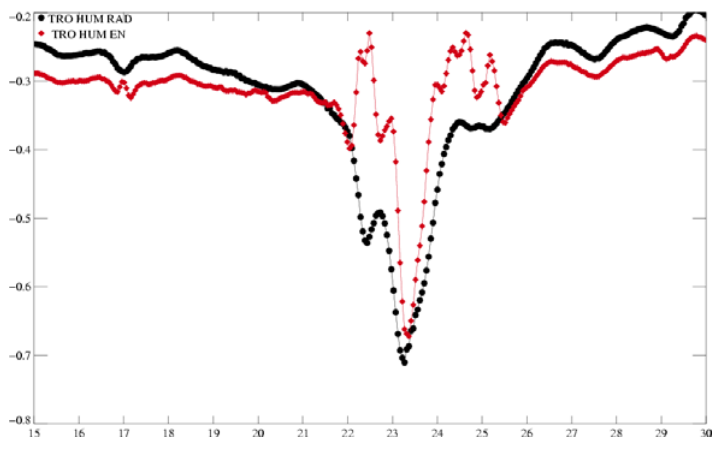
Figure 7. Envisat parametric formula calculated with Jason-1 TBs (red) compared to the radiometric correction (black) for Jason for TC Isabel (J1 track 50/cycle 62). Wet troposphere correction unit is m.